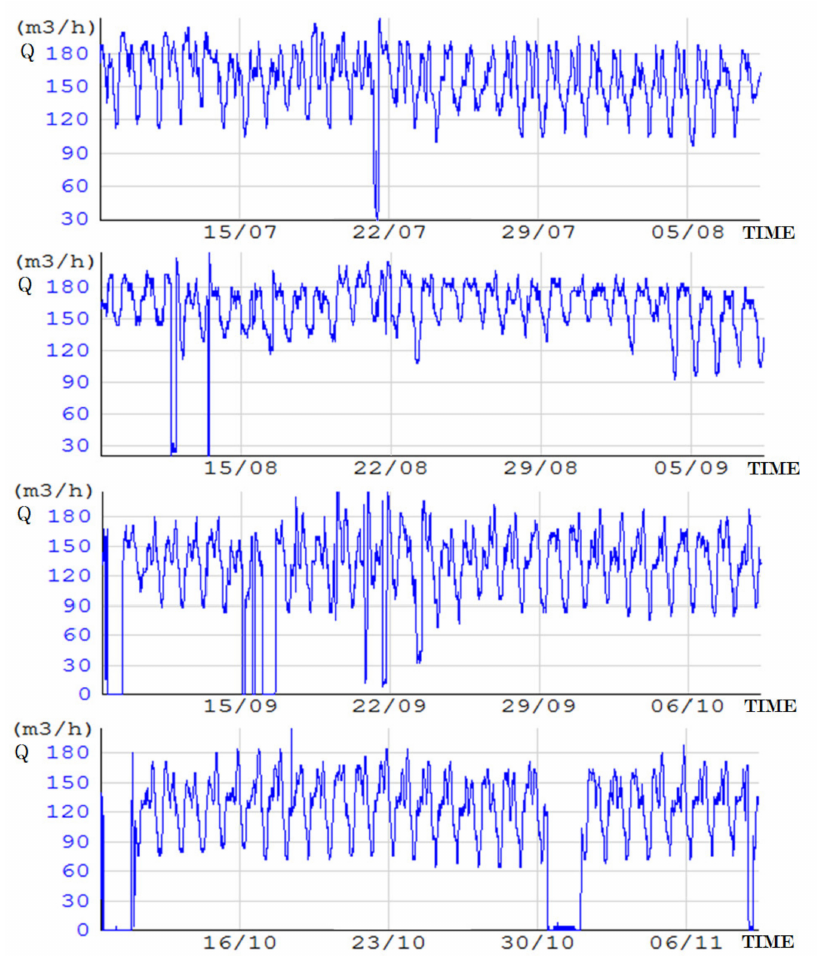
Figure 9. Water flow curves measured in the PRV during the months between July ( top ), August ( second from the top ), September ( third the from top ) and October ( bottom ).